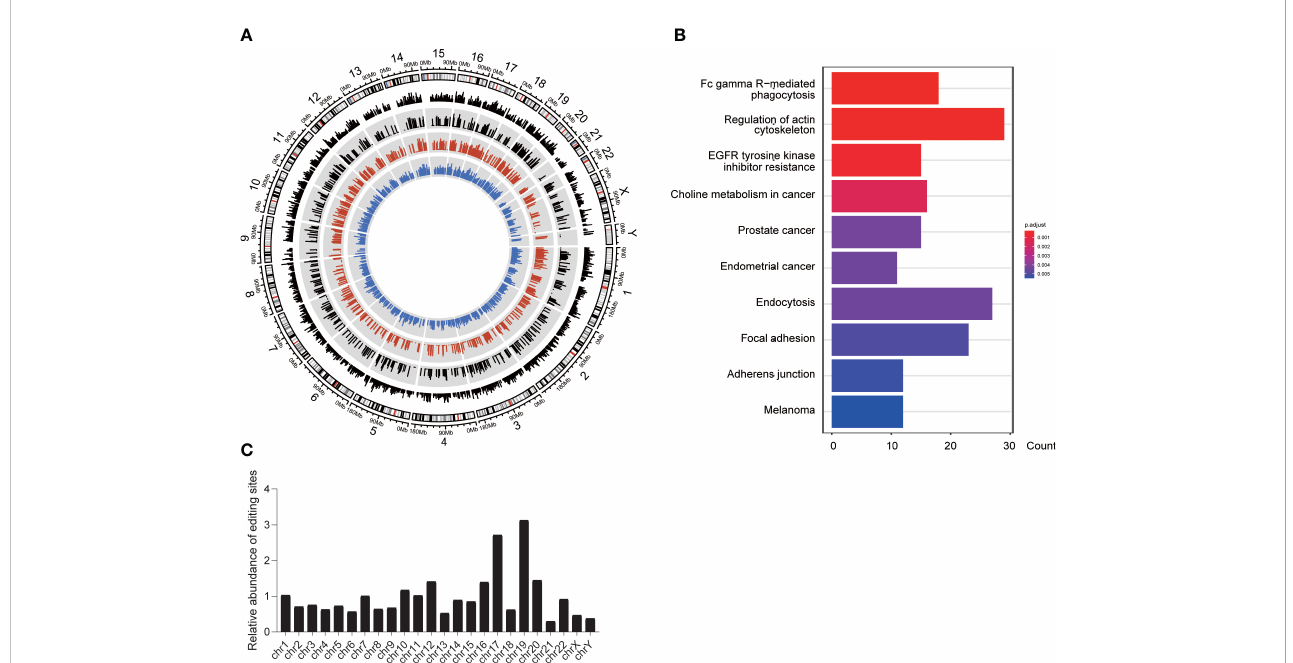
FIGURE 6 Positive selection of A-to-I DREs. (A) The F ST of DREs among three groups. The white background shows the F ST score of total DREs, whereas the gray background shows the DREs under positive selection (F ST >= 0.25). The black, red, and blue lines represent the FST score and the mean RNA editing level in the tumor and normal groups, respectively. (B) The pathway of genes with a positive signal. (C) The chromosomal distribution of DREs with a positive